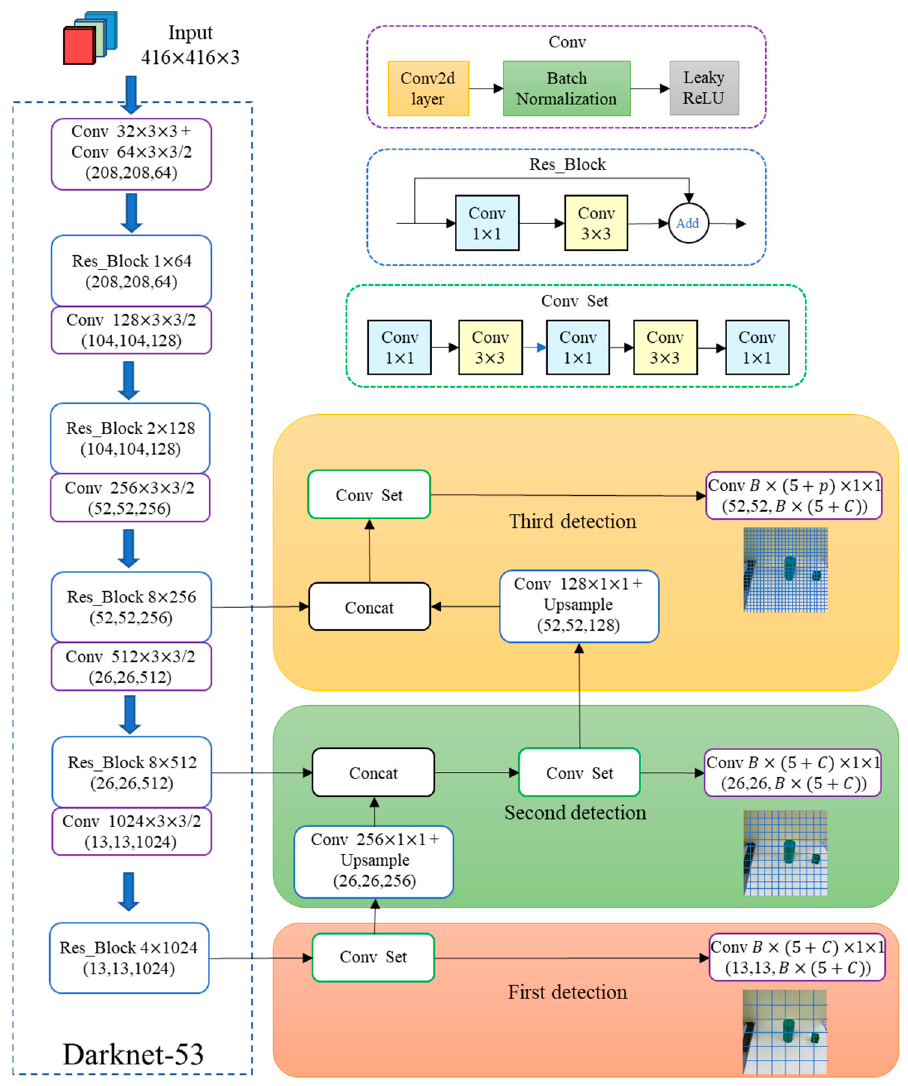
Figure 2. Schematic diagram of YOLO.